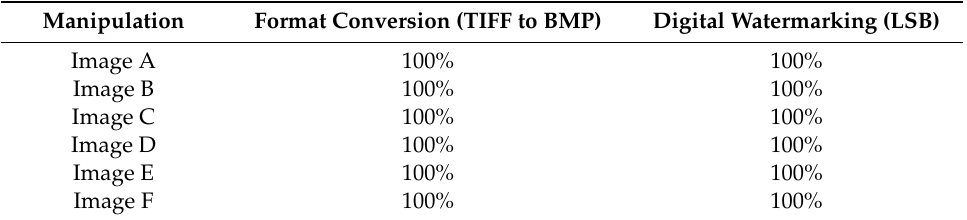
Table 1. The results of the robustness test1 ( T h is set to 0). Manipulation